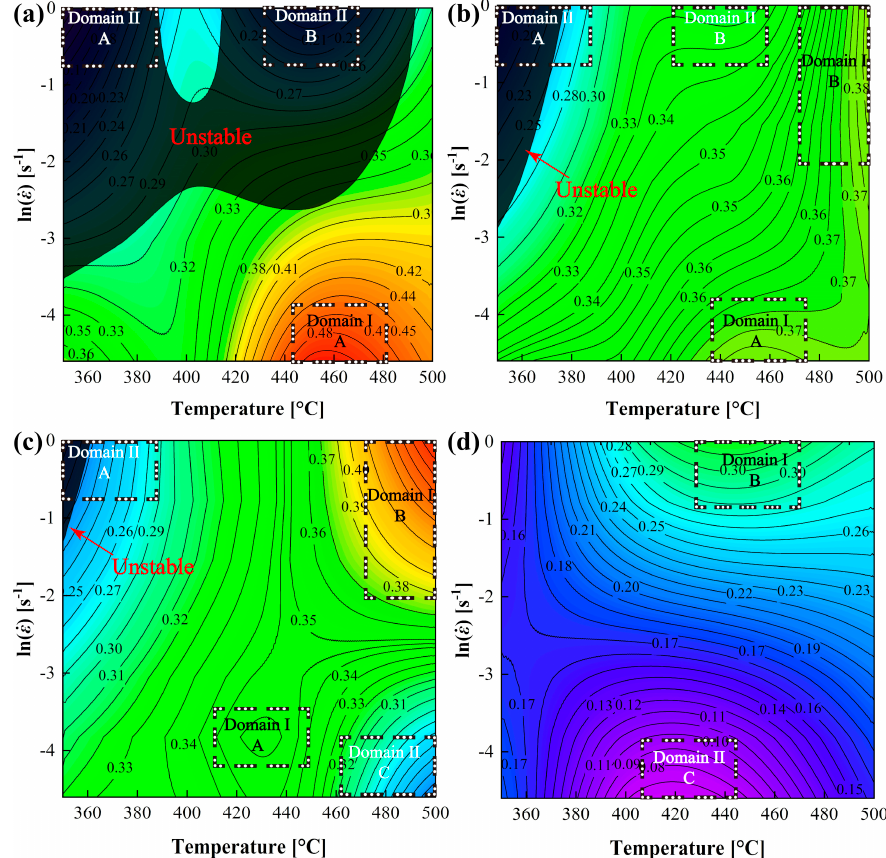
Figure 4. The strain sections of 3D hot processing maps for the true strain of ( a ) 0.69, ( b ) 0.92, ( c ) 1.20 and ( d ) 1.38.